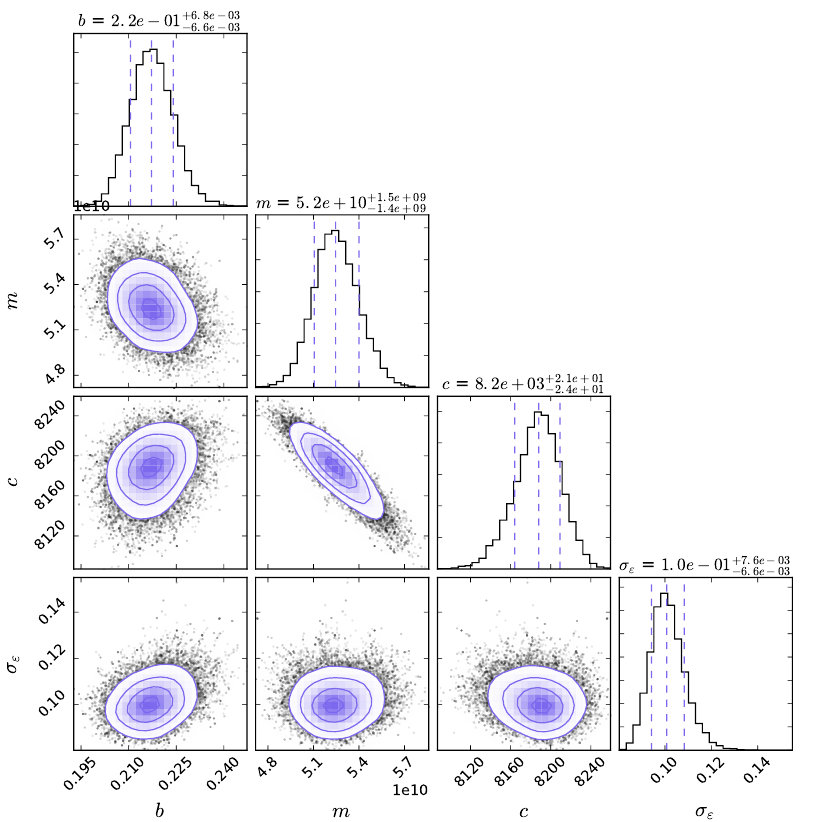
Figure A1. PCASP (low gain stage) calibration results following the new method. The model parameter solution ensemble is visualized in the same way as in Fig. 9.